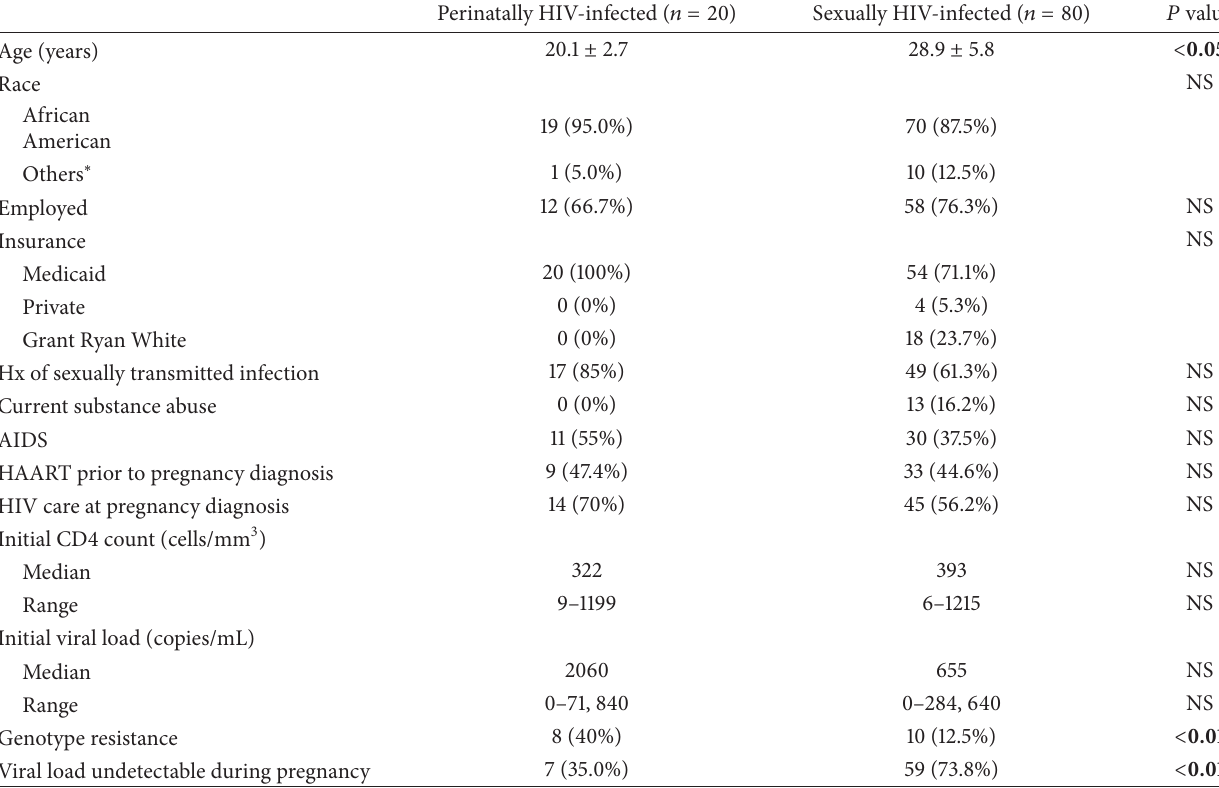
Table 1: Maternal characteristics of perinatally HIV-infected versus sexually HIV-infected